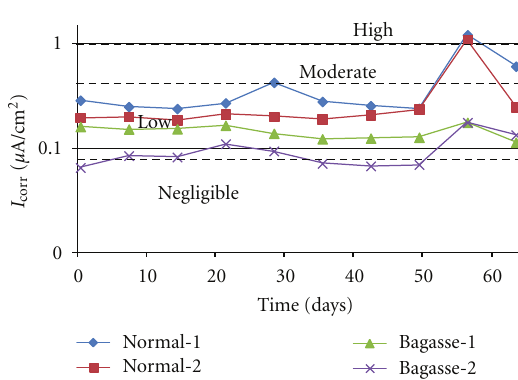
Figure 5: Corrosion current density of specimens.